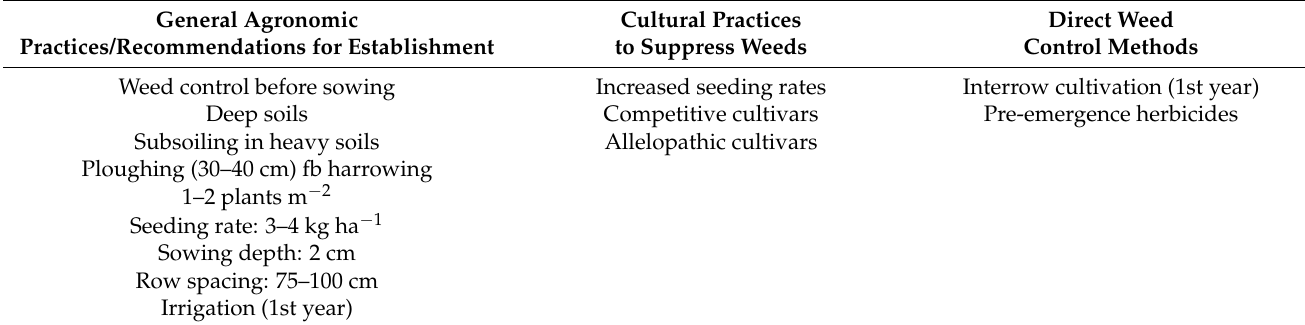
Table 4. General agronomic practices and recommendations for cardoon establishment, cultural practices to suppress weeds and direct weed control